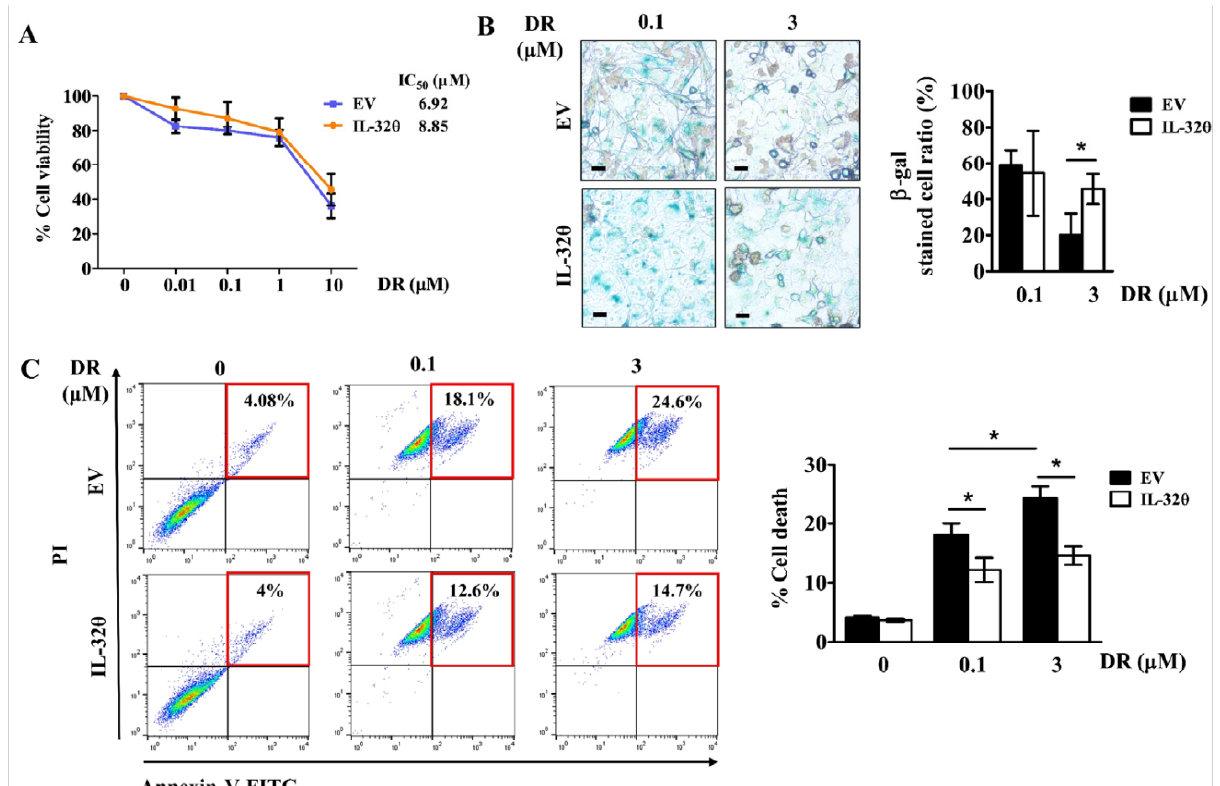
Figure 5. Effects of IL-32 θ on doxorubicin-treated breast cancer cells. ( A ) Cell viability quantified by MTS assays and IC 50 of different doses of DR. ( B ) Cells positive for SA- β -gal and count ratios (%). Scale bar, 20 µ m. ( C ) Ratios (%) of cell death measured by Annexin-V/PI staining, followed by flow cytometry. * p < 0.05 (Student t -tests). Results are representative of three independent